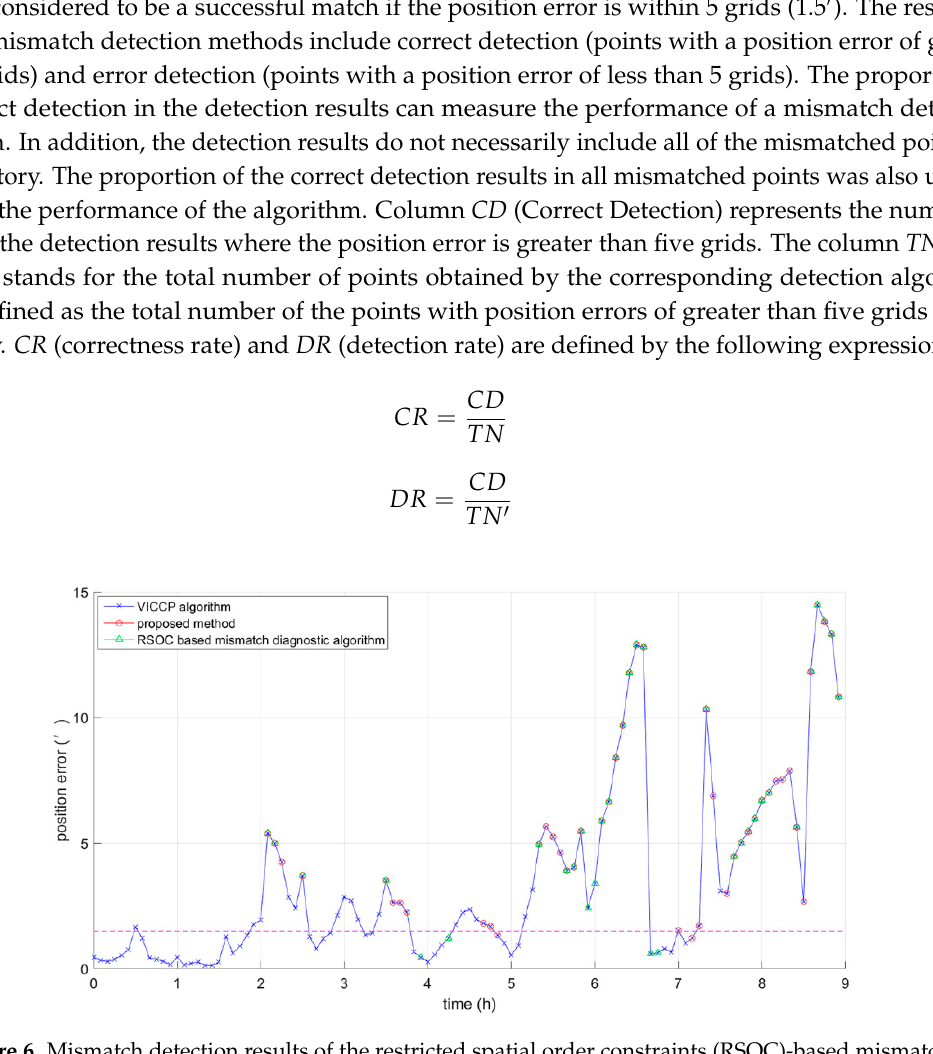
Figure 6. Mismatch detection results of the restricted spatial order constraints (RSOC)-based mismatch diagnostic algorithm and the proposed method. Table 4. Statistic results of the RSOC-based mismatch diagnostic algorithm and the proposed method.